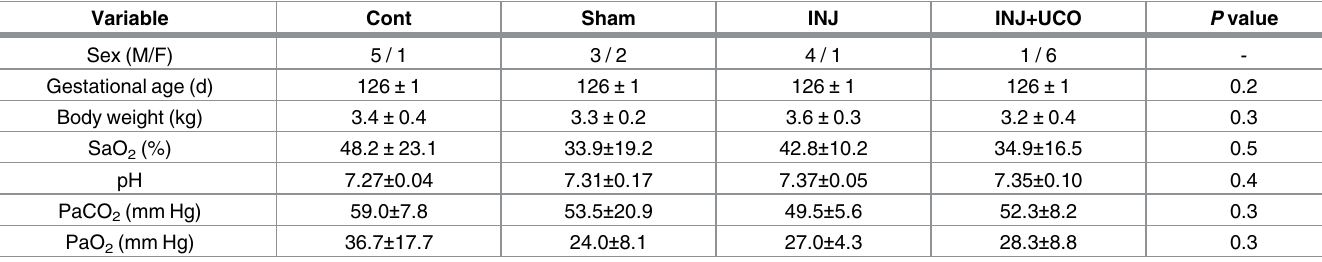
Characteristics of the Cont, Sham, INJ and INJ+UCO lambs groups in this study and their fetal blood gases at the time of intubation and cord clamping. Data are presented as mean ±